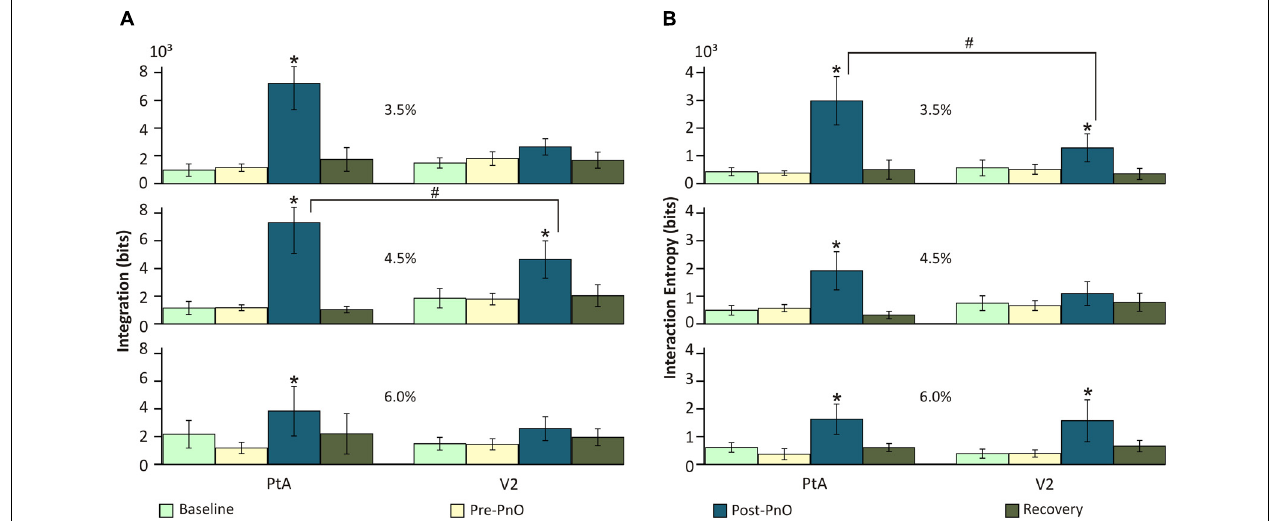
FIGURE 3 | Effect of PnO stimulation on integration and interaction entropy of cortical spike populations on day 1 PnO electrical stimulation produced robust increases in (A) integration and (B) interaction entropy in both PtA and V2. These changes were generally